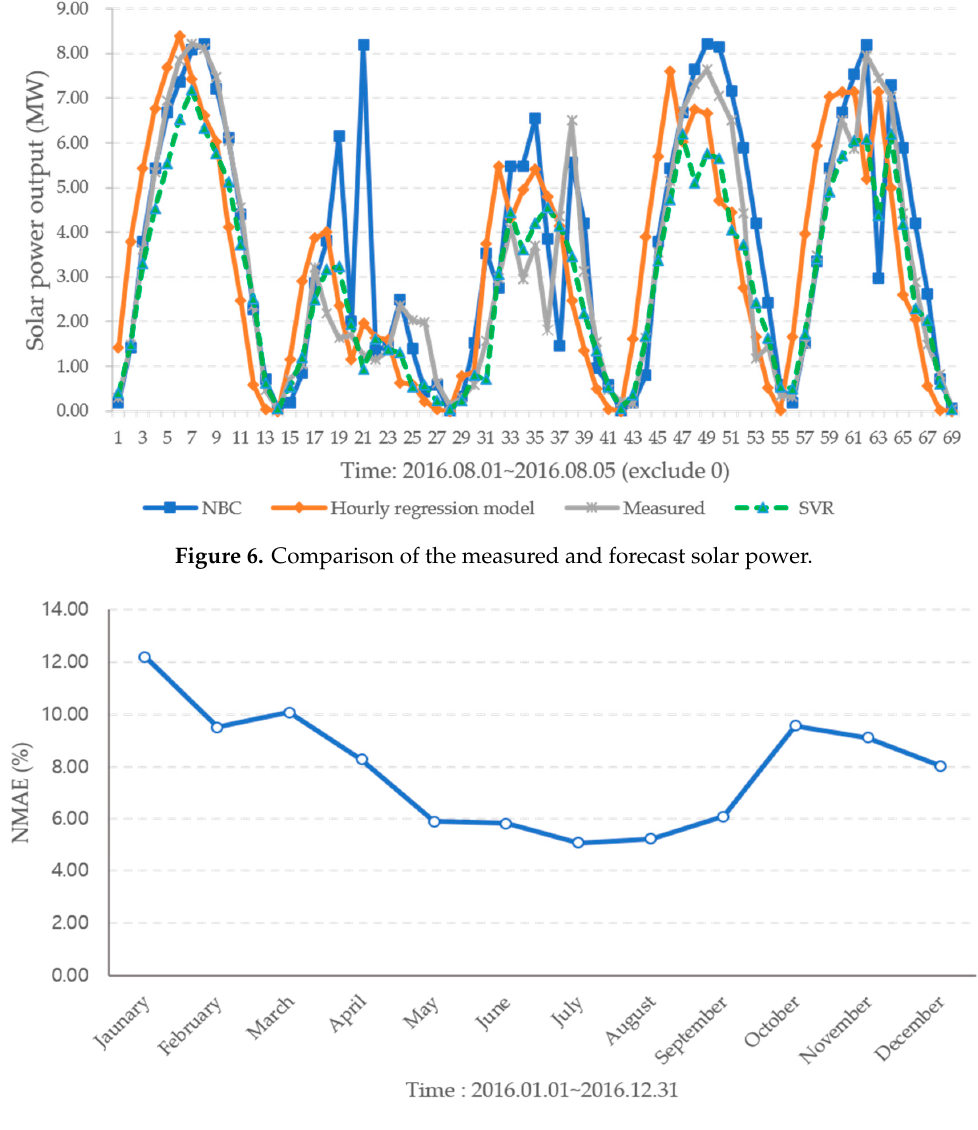
Figure 7. The NMAE for NBC model forecasting result in 2016.